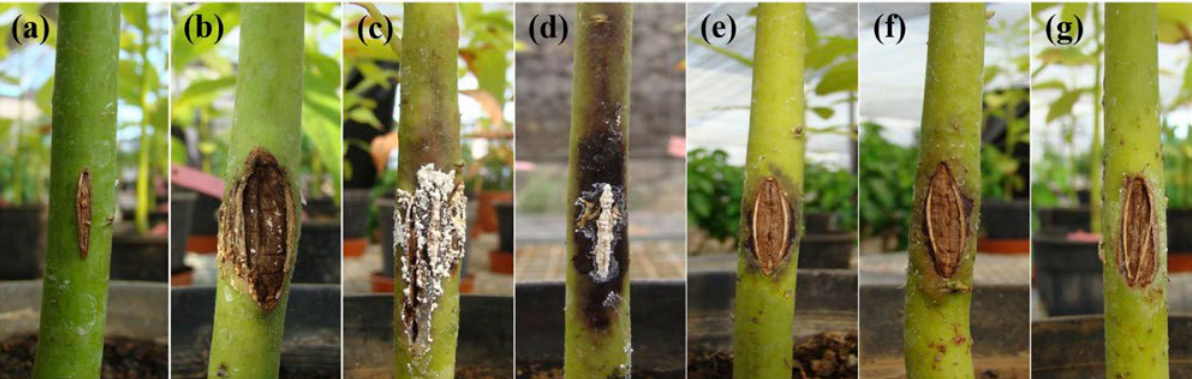
Figure 7. Lesions on stems of avocado seedlings at the end of the stem pathogenicity test: a, Control (uninoculated plants); b, Positive control ( P. cinnamomi isolate PcH15); c, P. palmivora C011; d, P. niederhauserii C051; e, P. multivora C005; f, P. nico- tianae C013; g, Pp. vexans C015. Note the absence of callus tissue at the edges of the wounds that were inoculated with P. palmivora and P. niederhauserii , as well as the exudation of white, sugary material that is commonly associated with avocado